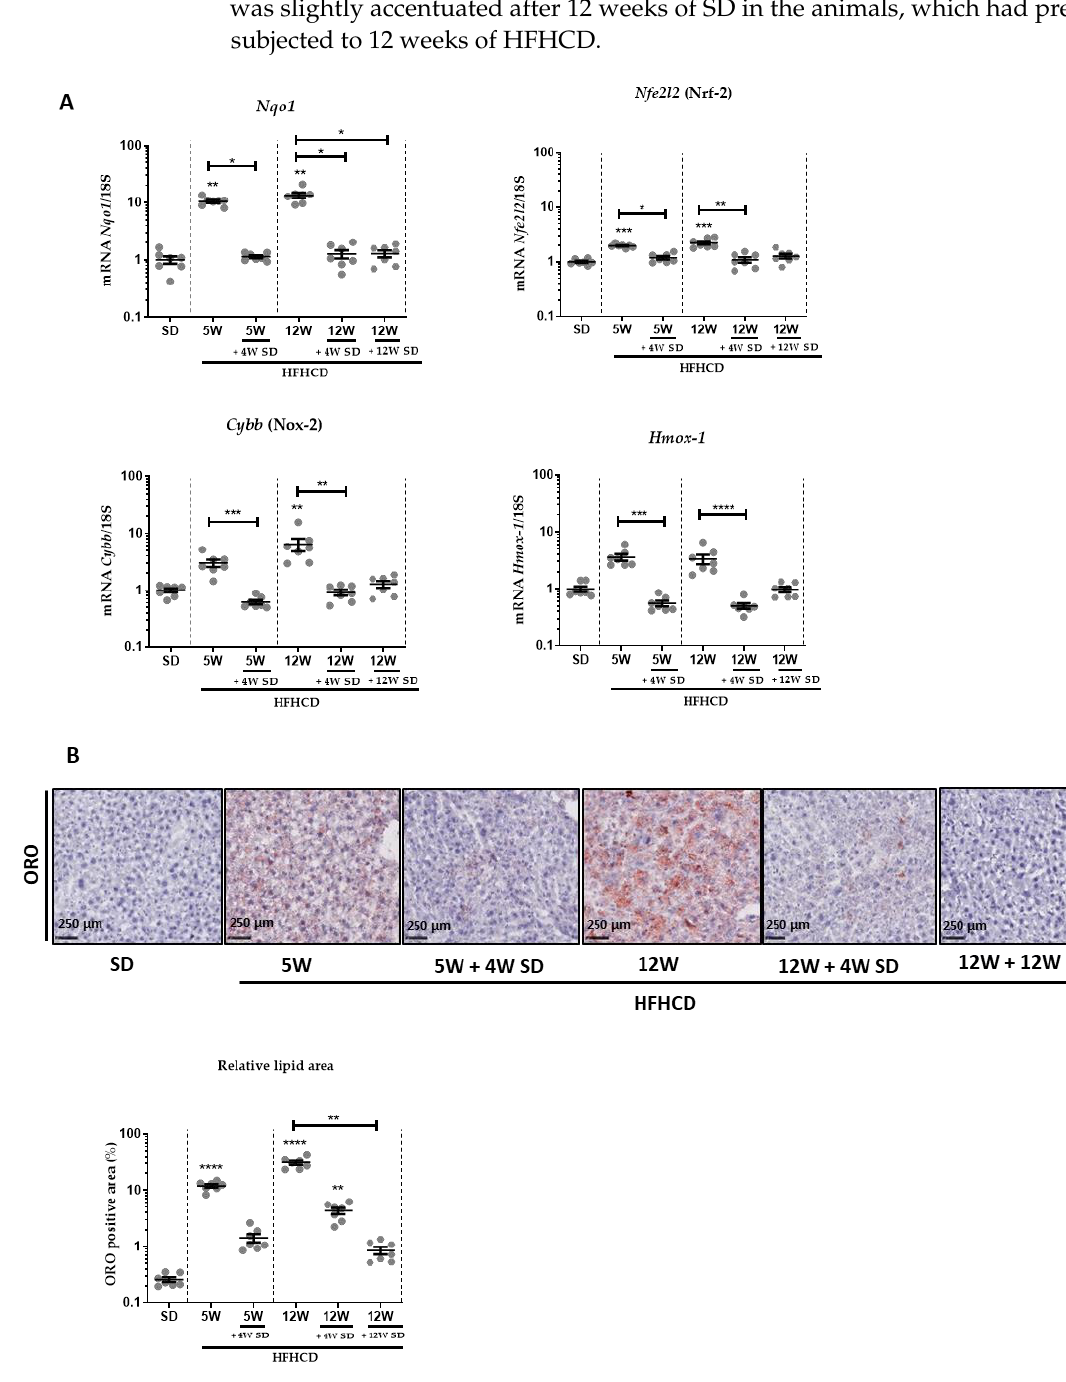
Figure 2. Dietary intervention reduced NASH-induced oxidative stress and steatosis. Six groups of seven male mice were given separate diet regimens of either a standard diet (SD) or a high-fat, high-cholesterol diet (HFHCD) for 5 or 12 weeks (W), with some groups returning to the SD on an additional period of 4 or 12 weeks. ( A ) Liver transcript expression of Nqo1, Nfe2l2 (Nrf-2), Cybb (Nox-2) and Hmox-1. ( B ) Oil red O (ORO) stained liver sections and quantification of ORO positive area (% area of lipid deposition). For all graphs, each dot represents an individual and error bars are expressed as means ± SEM (* p < 0.05, ** p < 0.01, *** p <0.001 and **** p <0.0001).